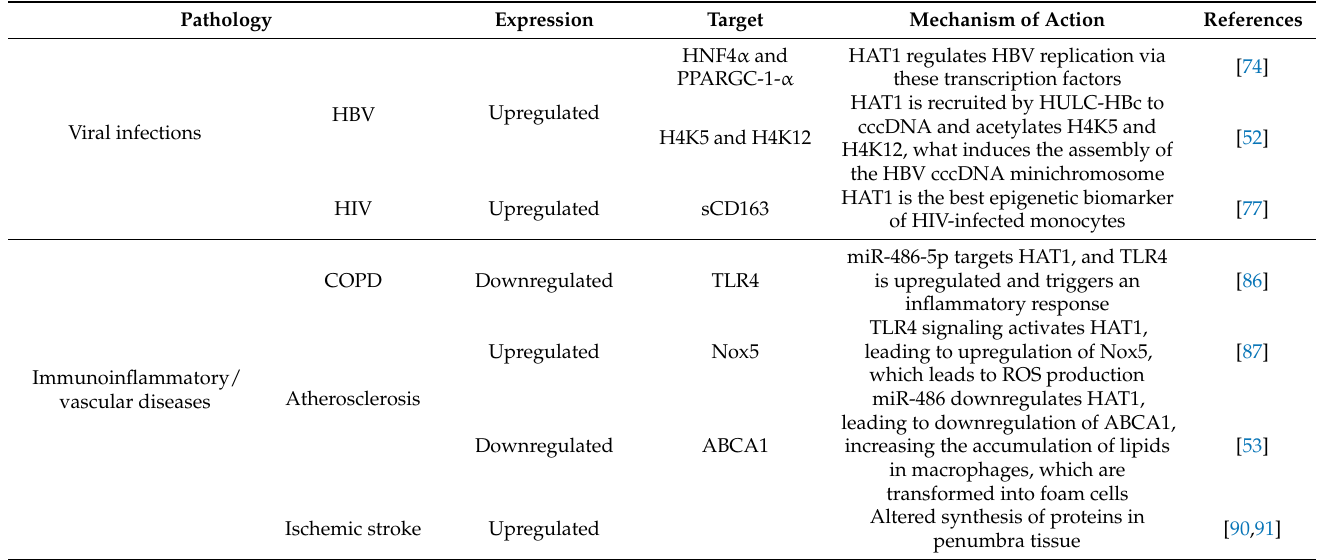
Table 2. HAT1 expression and function in viral infections and immunoinflammatory and vascular